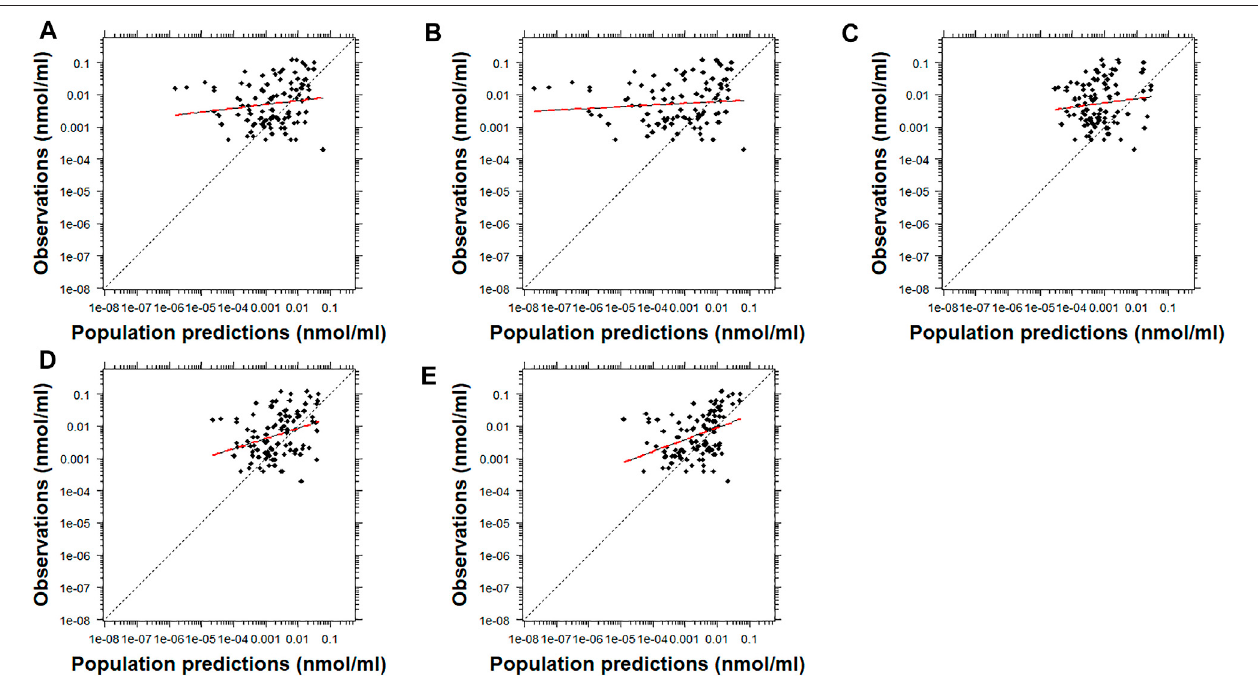
FIGURE 2 | Population predicted concentrations versus observations for risperidone. Model (A) : Kloosterboer et al., 2021; Model (B) : Sherwin et al., 2012; Model (C) :Fenget al.,2008;Model (D) :Feng etal.,2008withallometricscaling; andModel (E) :Thyssenet al.,2010.Thedashed blackand dashed redlinesrepresenttheline of identity and the least-squares regression curve,